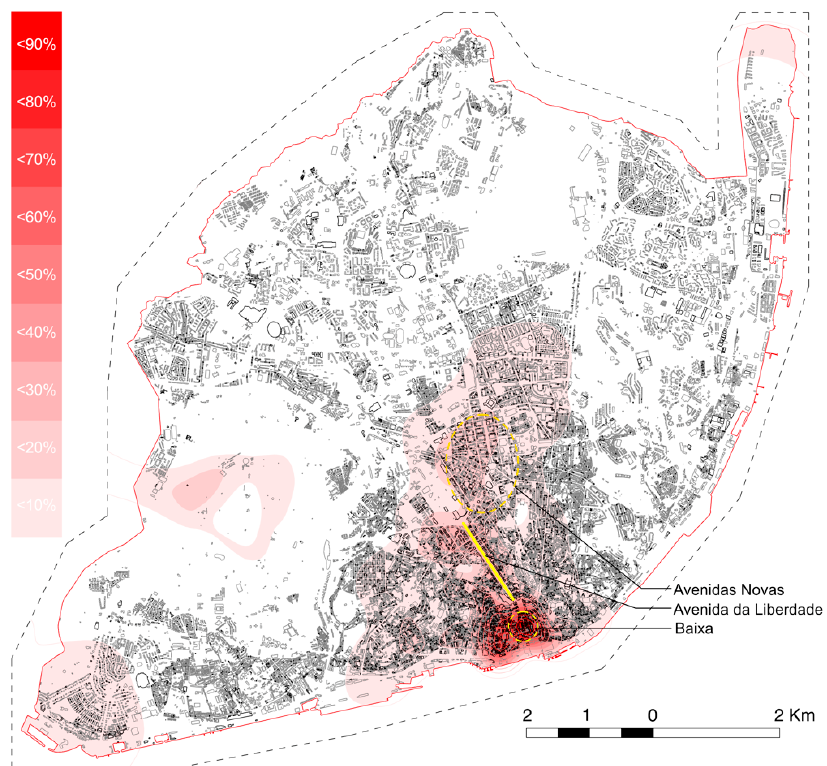
Figure 5. Dual KDE of building renovation permit requests in the 2010–2016 period in the city of Lisbon. Output of Grasshopper to Rhino. Source: Authors.